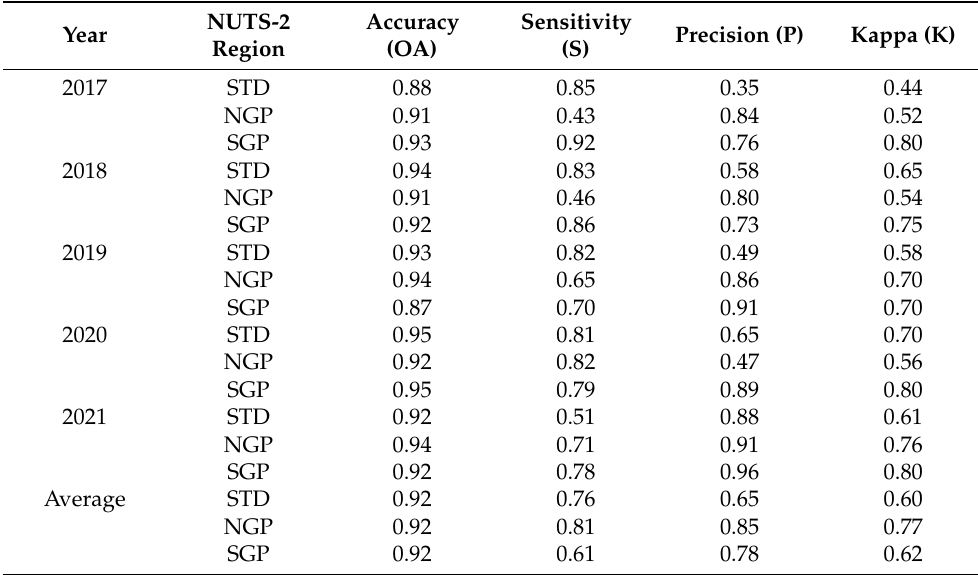
Table 1. Confusion matrix showing classification accuracy of reed cover mapped between the years 2017 and 2021 in STD, NGP, and SGP fish